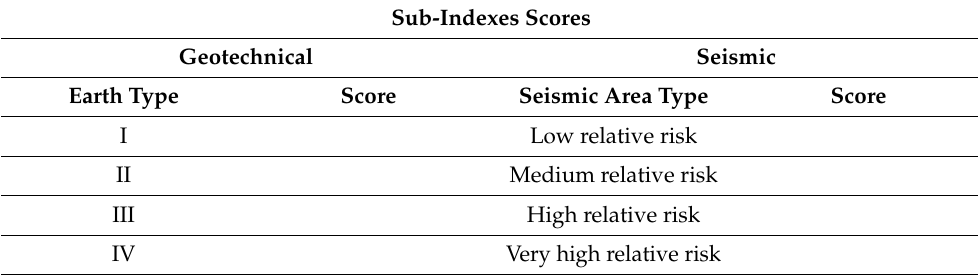
Table A7. Scores of Sub-Indexes in Geotechnical and Seismic Index.